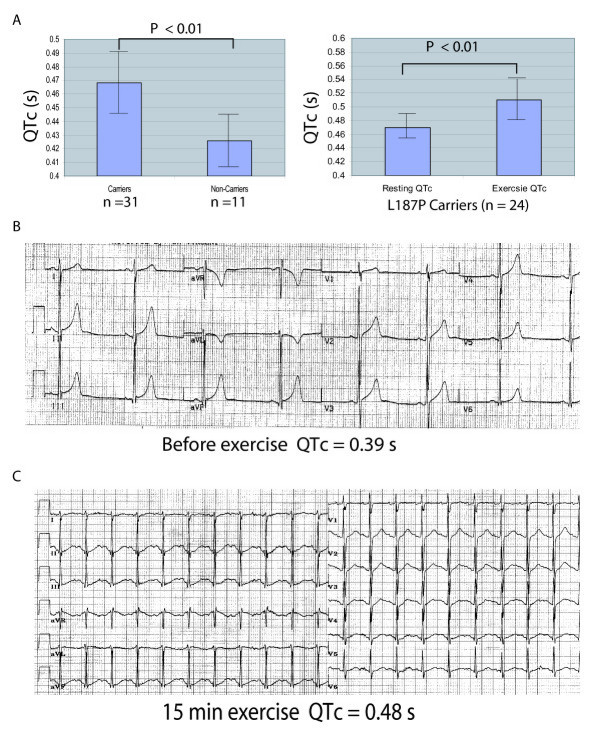
(A) Reduced penetrance of LQTS phenotype and effect of exercise on QTc. Mean QTc for carriers with mutation L187P and 11 non-carriers (left) and mean QTc for mutation carriers before (resting state) and during exercise (right). (B, C) Example of reduced penetrance of LQTS phenotype at baseline. Initial ECG (B) and ECG after 15-min exercise (C) are shown for a 29 year old, male, asymptomatic mutation L187P carrier.